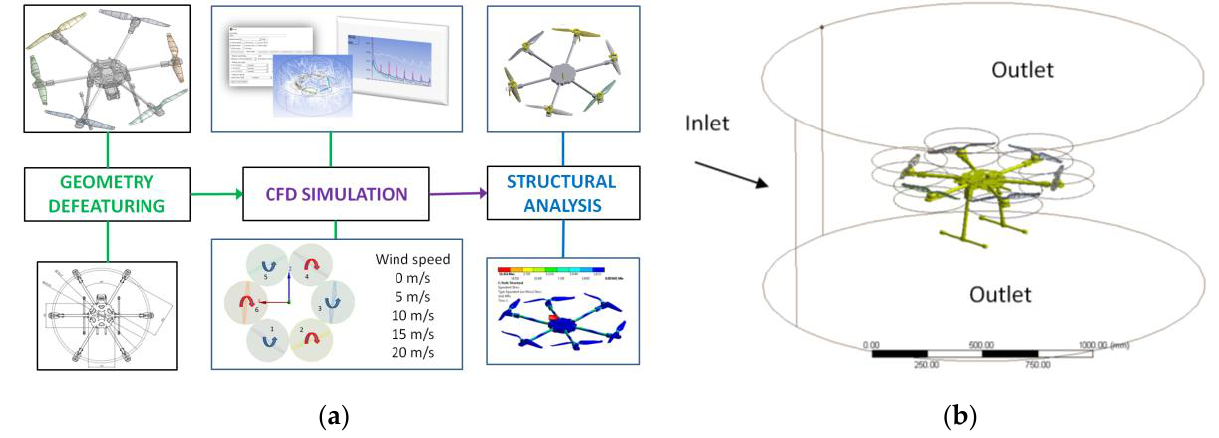
Figure 35. Fluid dynamics simulation. ( a ) CFD approach; ( b ) Enclosure.